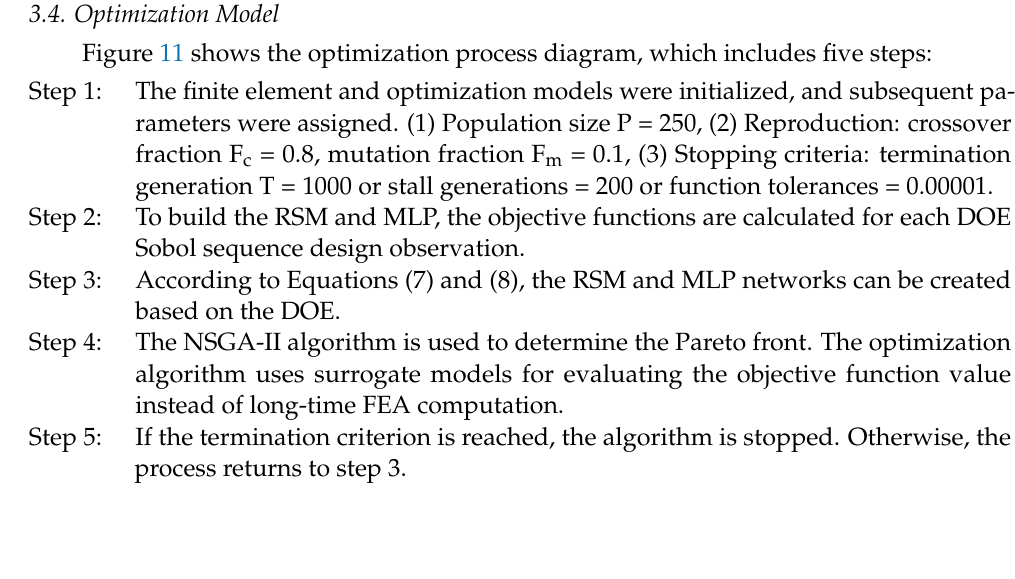
Figure 10. Pairwise projection of variables (Sobol sequence